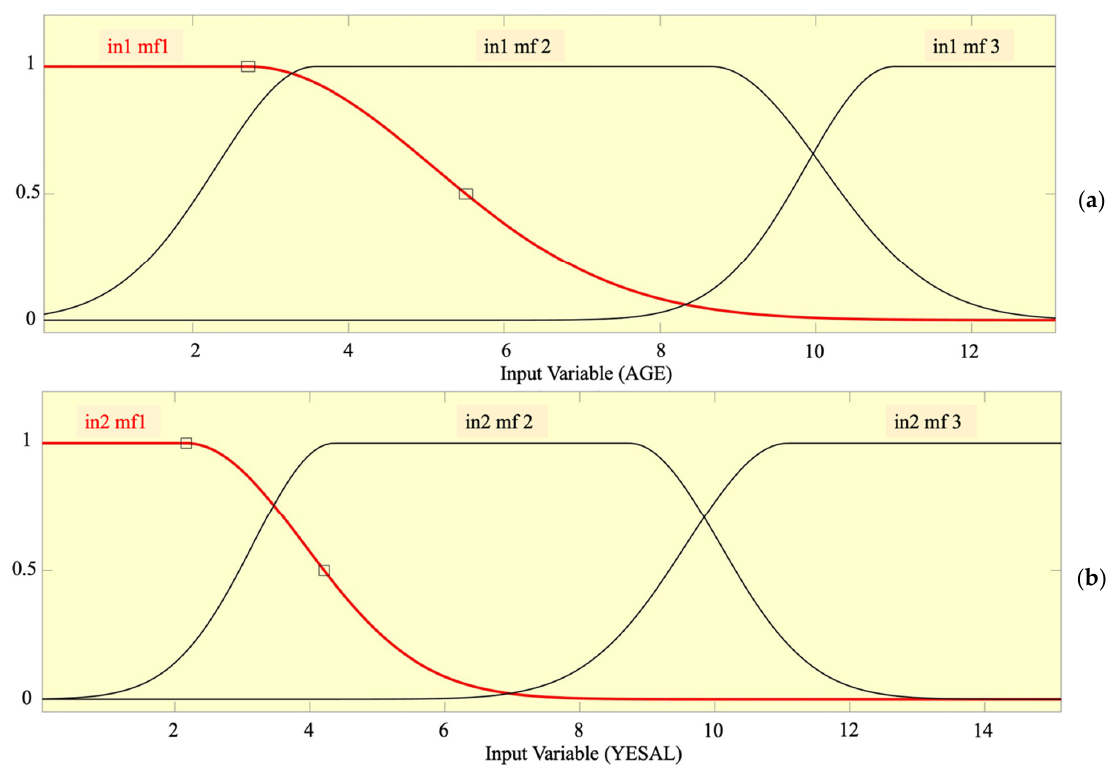
Figure 10. Final MFs for AC input variables of ( a ) AGE and ( b ) YESAL.